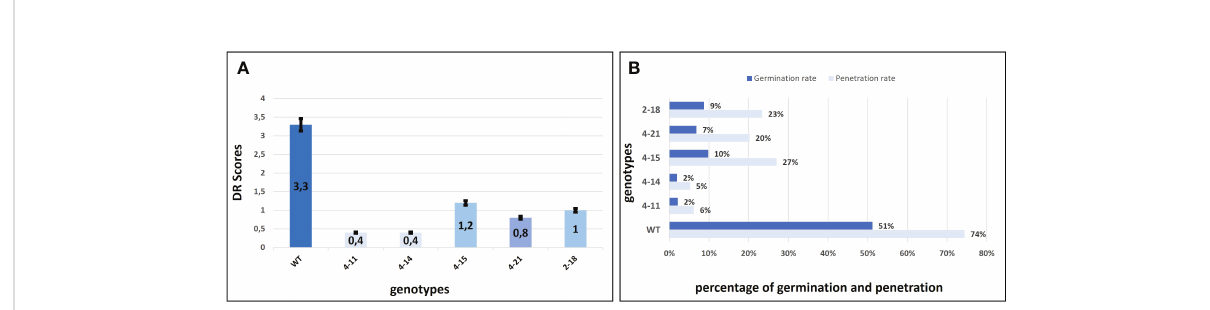
FIGURE 4 Evaluation of the DR scores against PM and P. xanthi penetration/germination rates at ten-day post-inoculation. (A) DR scores of wild-type ADR27 and mutant plants were generated means of the inoculated fi ve leaves for each genotypes at 10 dpi (Table 1) and same colors indicated that there is no difference for DR scores statistically according to standard deviation bar. The lowest DR scores were observed in 4-11 ( CsaMLO8 /11 del ) and 4-14 ( CsaMLO1 A137N /8/11 del ). The DR scores were statistically similar for 4-15 and 2-18 plants having CsaMLO1 mutation. 4-21 was determined as CsaMLO1 /11 del mutant and the DR score was lower than CsaMLO1 del even if higher DR score than 4-11 and 4-14.